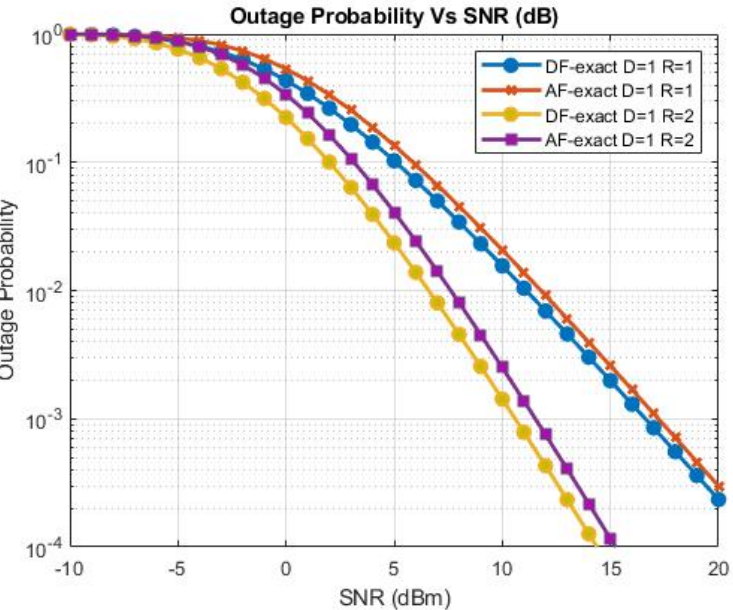
Figure 14. Outage Probability vs SNR at different K values . Table 2. Comparison table.